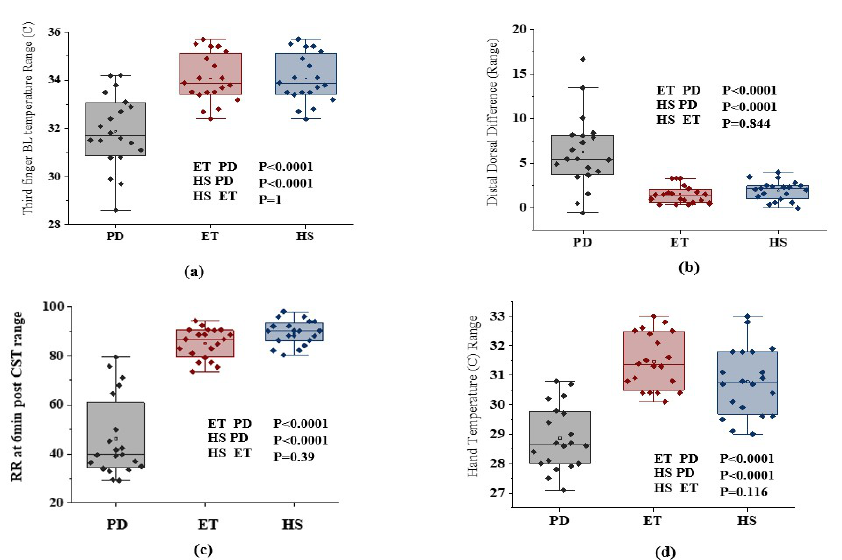
Figure 5. Comparison of three groups: ( a ) distribution of third finger BL temperature ©; ( b ) distri- bution of DDD of third finger; ( c ) distribution of RR at 6 min post-CST ©; ( d ) distribution of hand temperature ©.